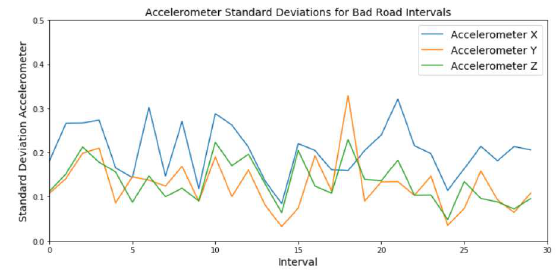
Figure 1. Proposed Architecture